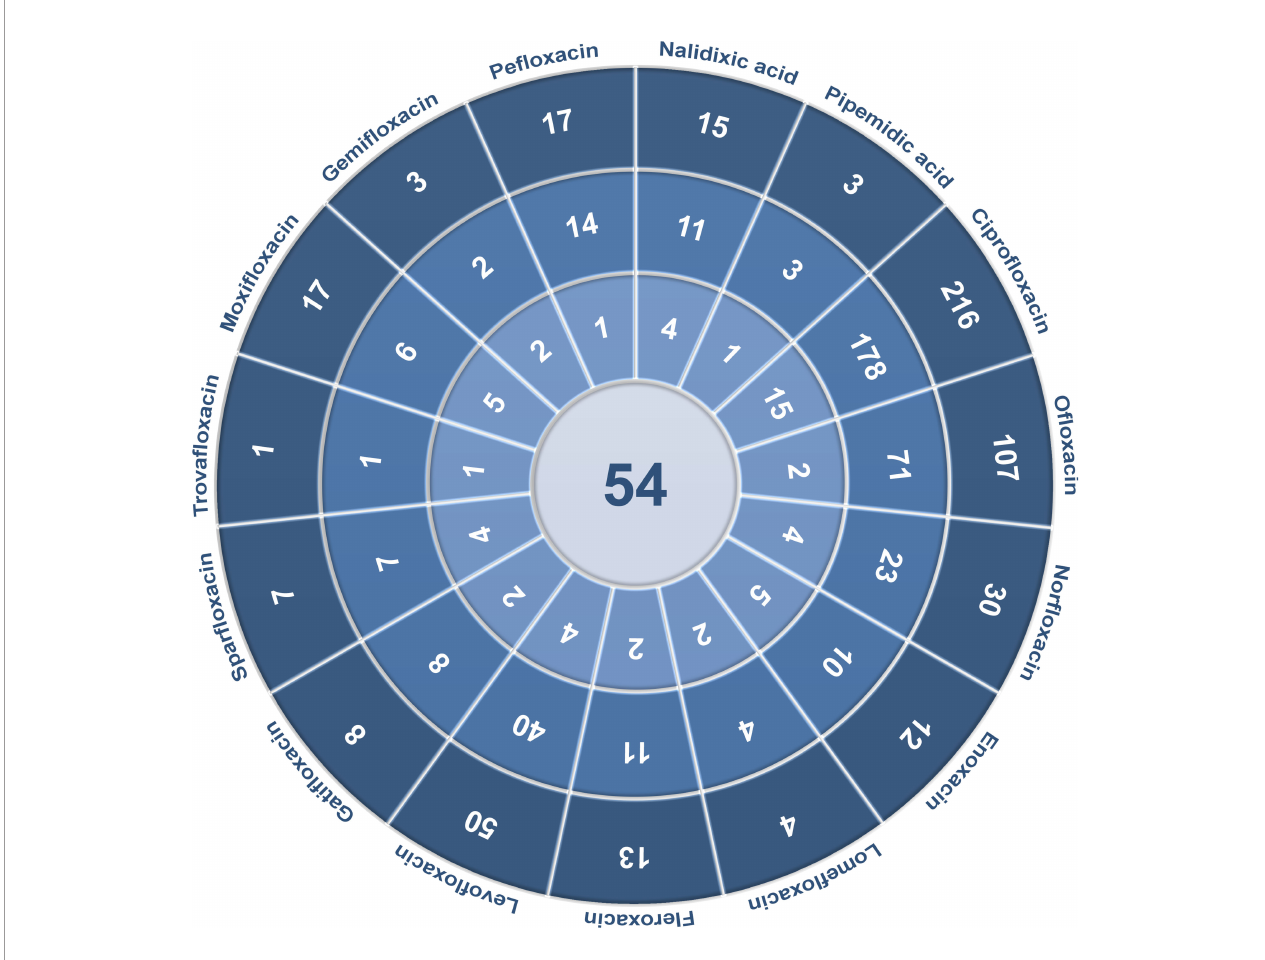
FIGURE 2 | Detailed analysis of data